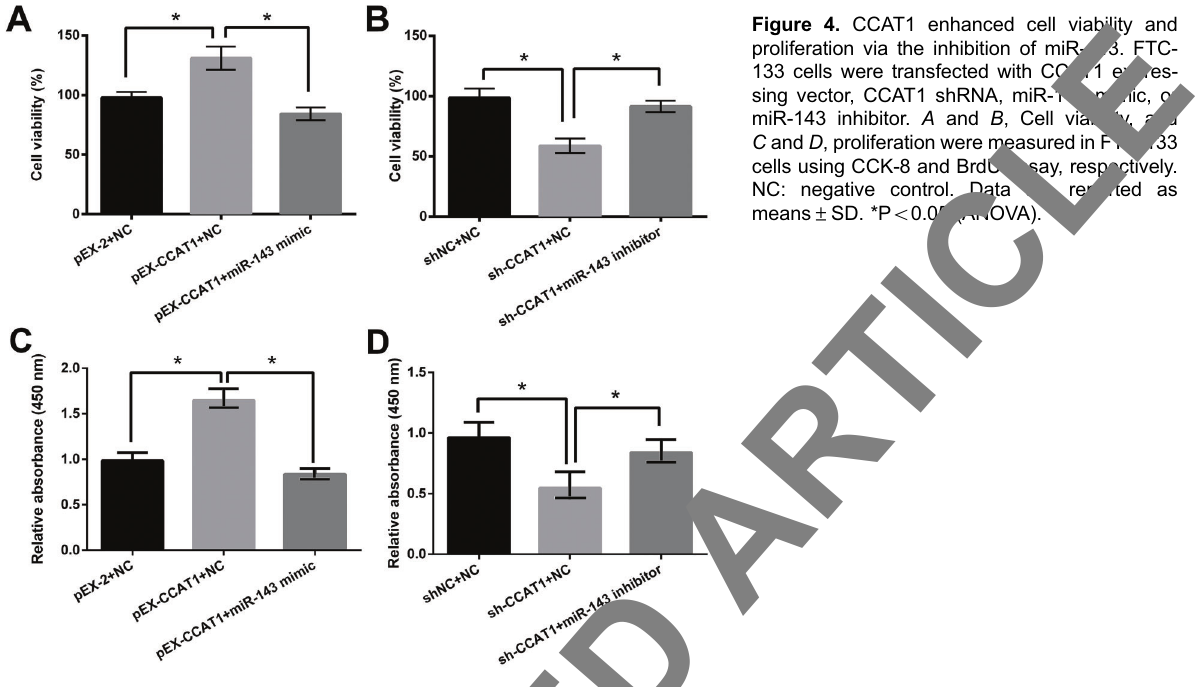
Figure 4. CCAT1 enhanced cell viability and proliferation via the inhibition of miR-143. FTC- 133 cells were transfected with CCAT1 expres- sing vector, CCAT1 shRNA, miR-143 mimic, or miR-143 inhibitor. A and B , Cell viability, and C and D , proliferation were measured in FTC-133 cells using CCK-8 and BrdU assay, respectively. NC: negative control. Data are reported as means ± SD. *P o 0.05